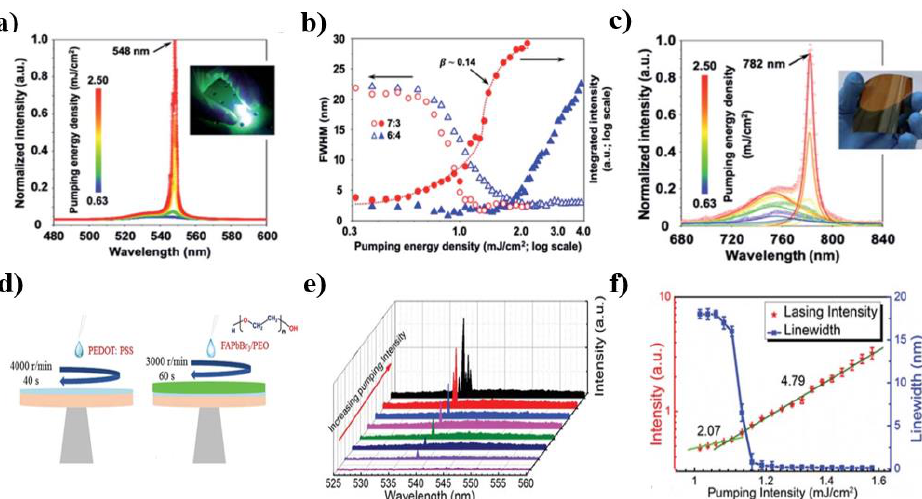
Figure 4. ( a ) Lasing characteristics of MAPbBr 3 organic–inorganic metal-halide perovskites. ( b ) The light–light curves extracted from the films were synthesized at different volume ratios. ( c ) Lasing characteristics of solvent-engineered MAPbI 3 perovskite thin films. The images ( a – c ) were adapted with permission from Ref. [88]. Copyright 2020 The Royal Society of Chemistry. ( d ) The preparation of the PEDOT:PSS and the FAPbBr 3 /PEO layers. ( e ) Two-photon pumped random lasing spectra versus pumping intensity. ( f ) Two photon-pumped random lasing intensity and FWHM versus pumping intensity. The images ( d – f ) were adapted with permission from Ref. [81]. Copyright 2018 The Royal Society of